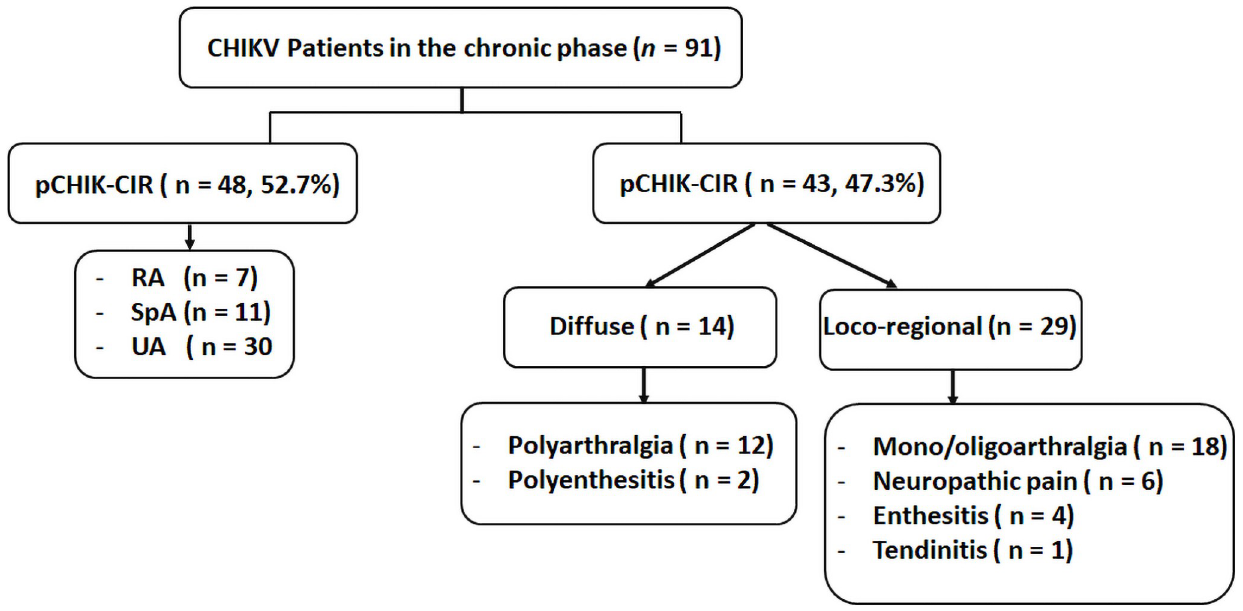
Fig 1. Rheumatic manifestations in patients with chronic CHIKV infection. CHIKV, Chikungunya virus; pCHIK-CIR, post-chikungunya chronic inflammatory rheumatism; pCHIK-MSD, post-chikungunya musculoskeletal disorder; RA, rheumatoid arthritis; SpA, spondyloarthritis; UA, undifferentiated arthritis.